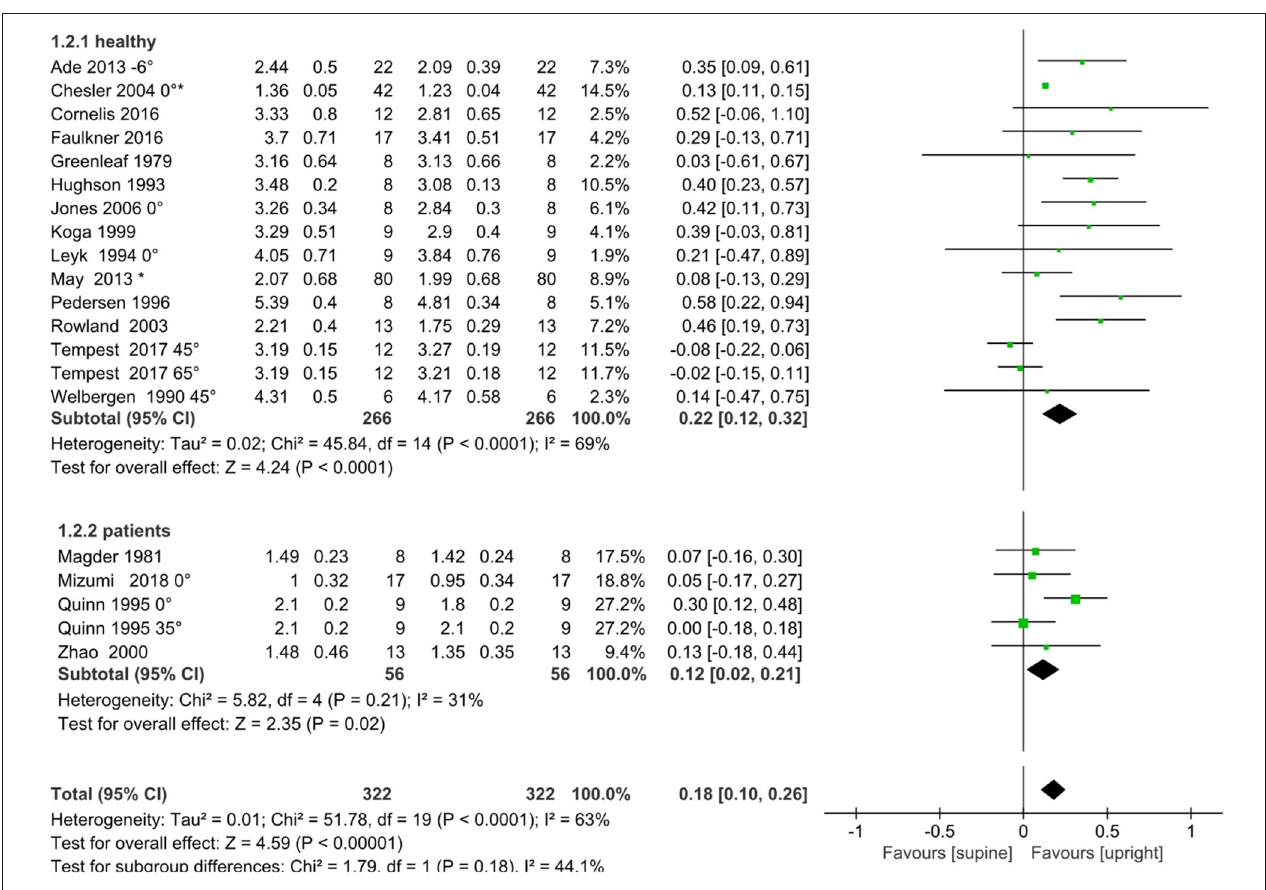
FIGURE 3 | Meta-analysis results for absolute VO 2peak (L/min), including overall pooled effects and subgroup effects of the healthy and the cardiopulmonary disease patients. A degree ( ◦ ) marker after the reference refers to the angle between upper body and horizontal plane in the supine position. References without a degree symbol indicates that the details were unavailable in the original text. An asterisk means that the original text’s grouping data are combined according to the formula in Cochrane 7.7, because the angle between upper body and horizontal plane is the same in the supine